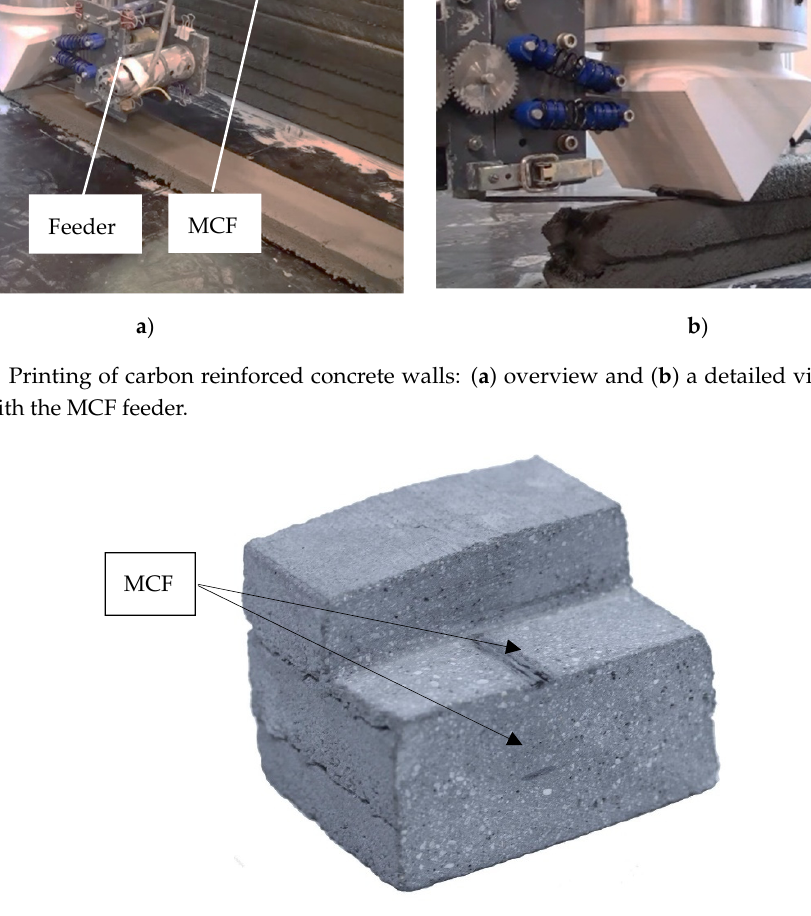
Figure 10. Cut-out of a printed wall showing MCF reinforcement between concrete layers.